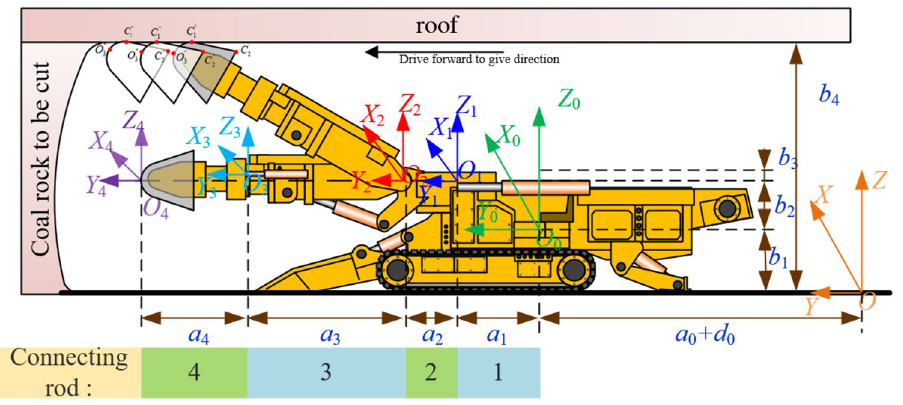
Figure 2. Kinematic coordinate system of